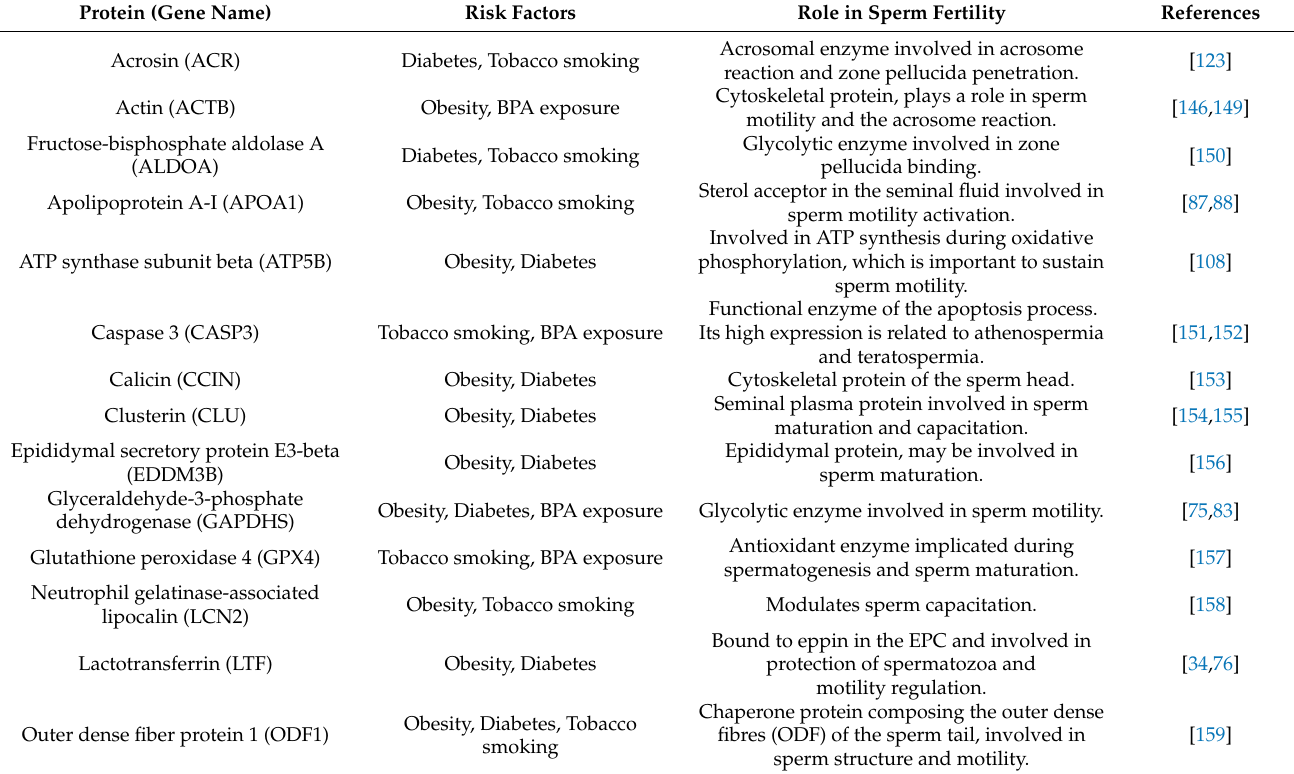
Table 2. Proteins associated with fertility and deregulated in relation to several male infertility risk factors. Protein (Gene